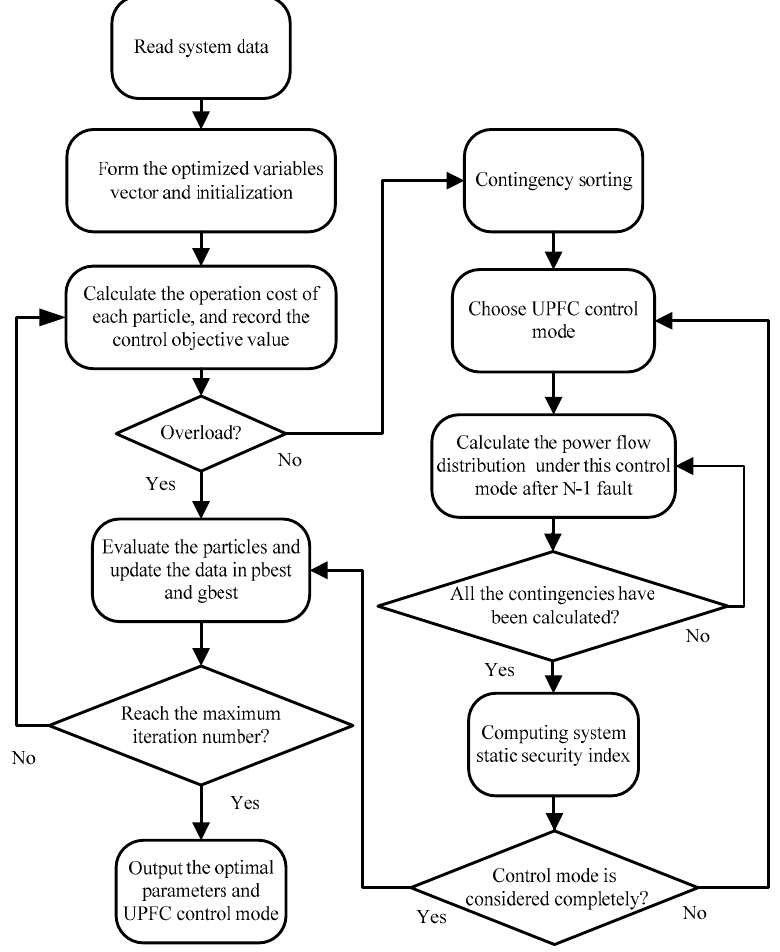
Figure 6. The flowchart of power flow optimization with UPFC control modes.